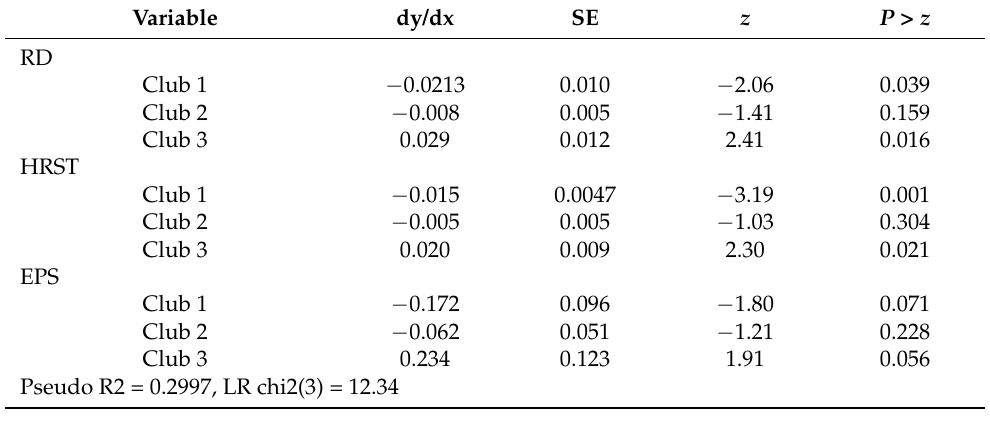
Table 2. Marginal effects on probabilities.